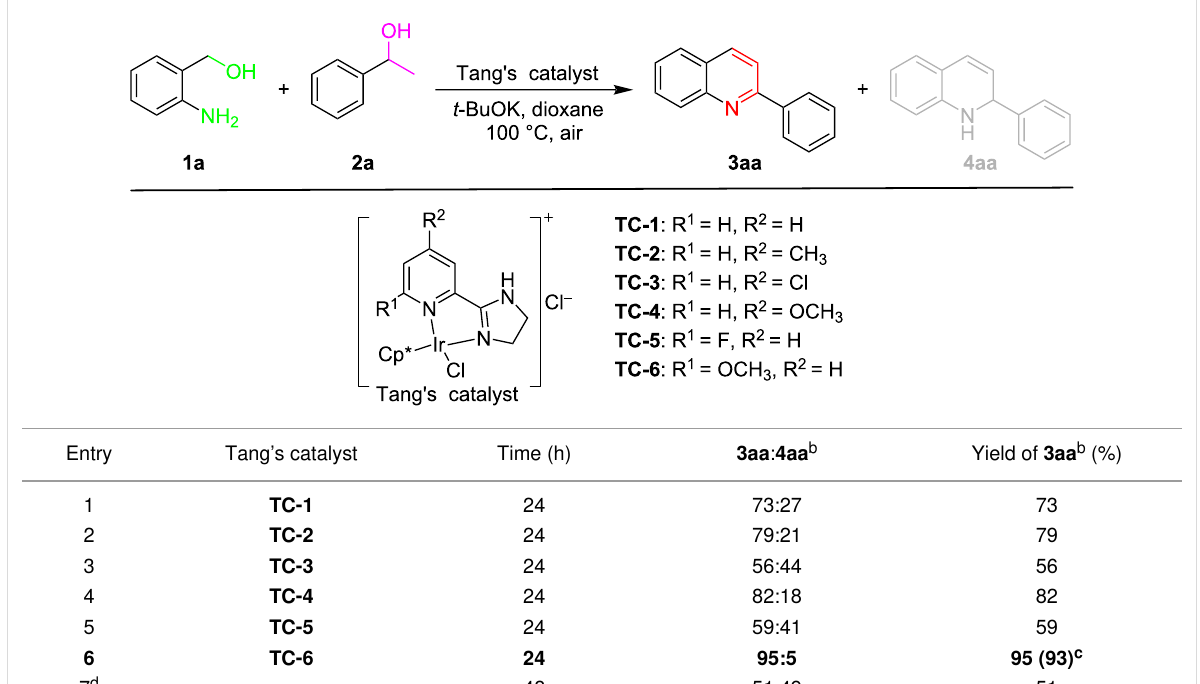
Table 1: Optimization of catalyst for ADC reaction of 2-aminobenzyl alcohol and 1-phenylethanol.